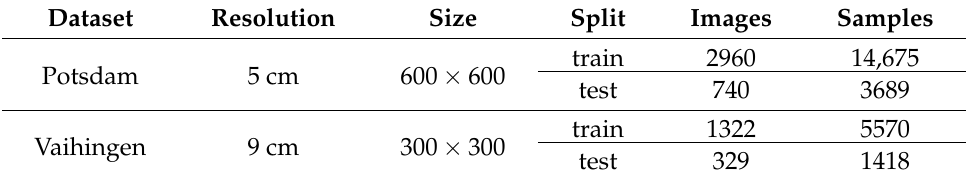
Table 1. Statistics of the datasets, including the resolution, size, image number, and mask number. Dataset